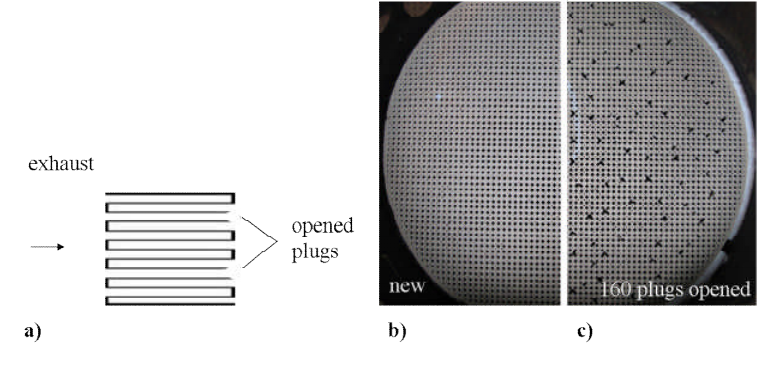
Figure 3. Diesel particulate filter with opened channels. (a) Principle. (b) Photography of the original device with closed channels. (c) Photography of the device with 160 opened